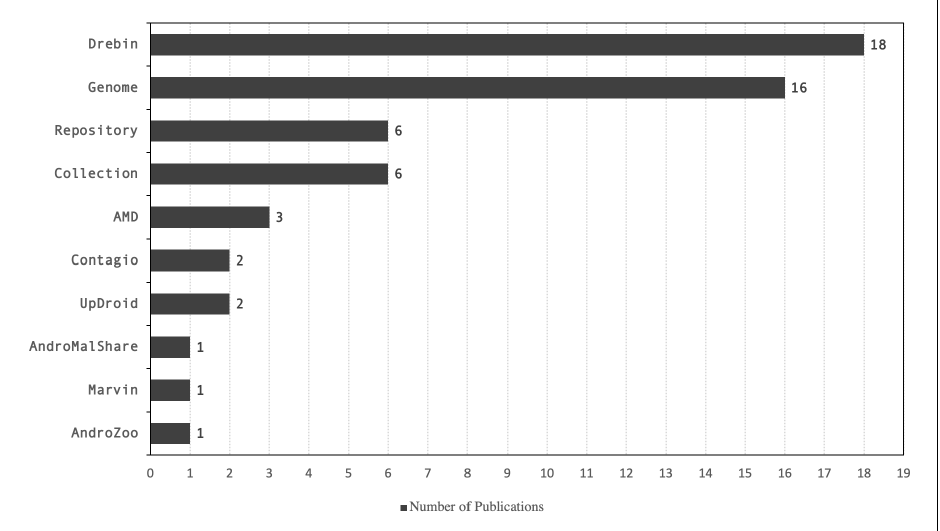
Figure 4. Dataset Reported by Publications, where the x -axis represents the number of publications and the y -axis represents the